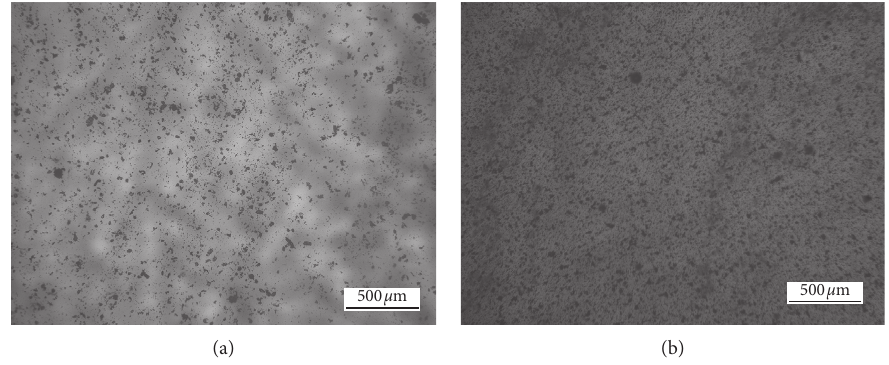
Figure 10: Scheelite and calcite particles ( − 10 μ m) in ultrapure water: (a) pH 8; (b) pH 10.